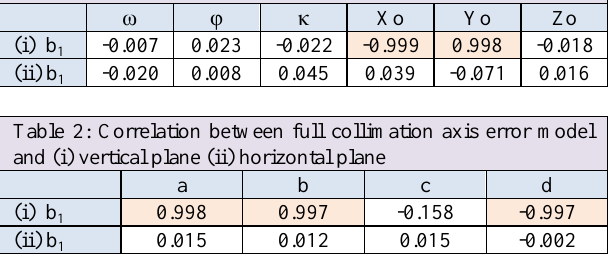
Table 1: Correlation between full collimation axis error model and the EOPs of (i) scan 4 (ii) scan 2